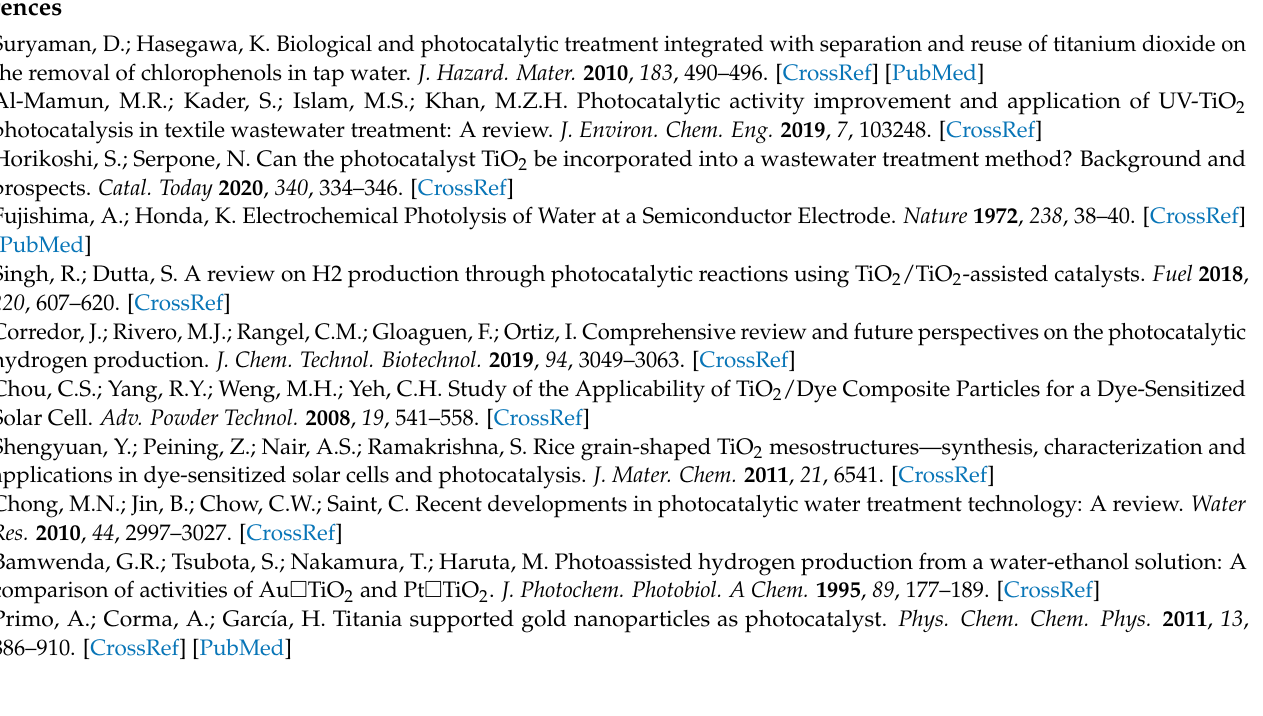
assemblies with different thicknesses. Figure S7: The total decomposition amount of MB versus film thicknesses. Figure S8: The transmittance versus thickness of DIO photocatalytic assemblies. Table S1: Adsorption amounts of MB on the TiO 2 particle assembly, the TiO 2 particle assembly immobilized by silica frame (TiO 2 /SiO 2 ), and the DIO assembly. Table S2: MB decomposition rate constant of each DIO